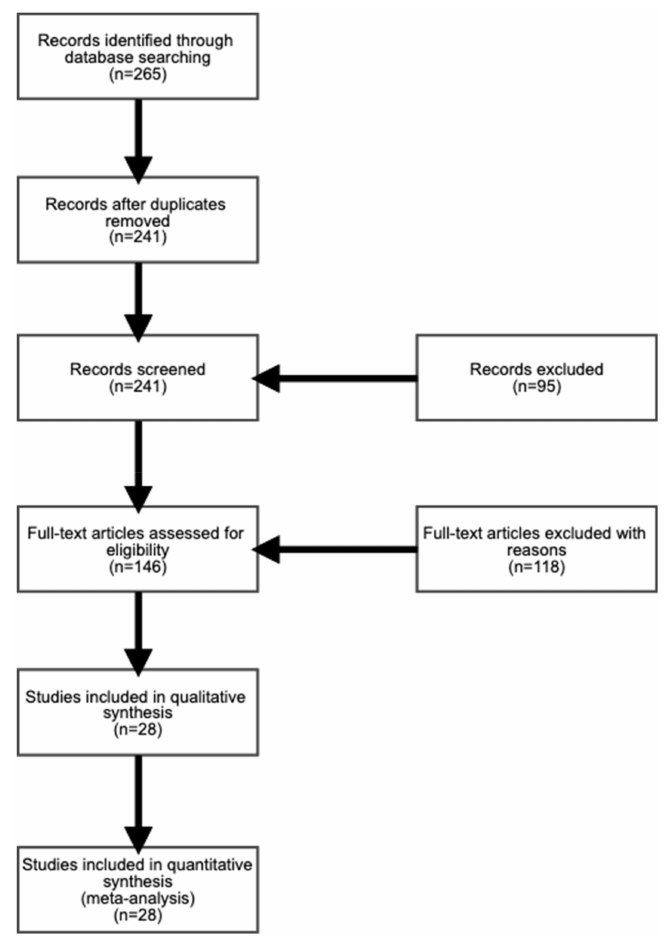
Figure 2. Flow diagram of identification and inclusion of